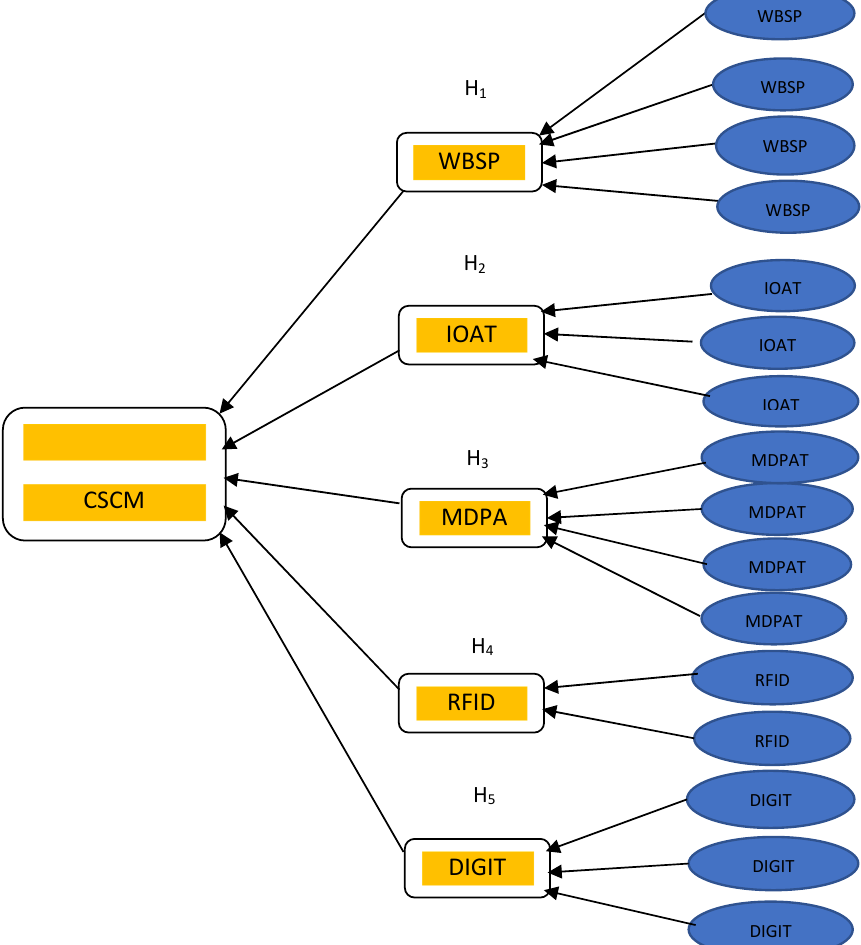
Fig. 2. Conceptual model of positive